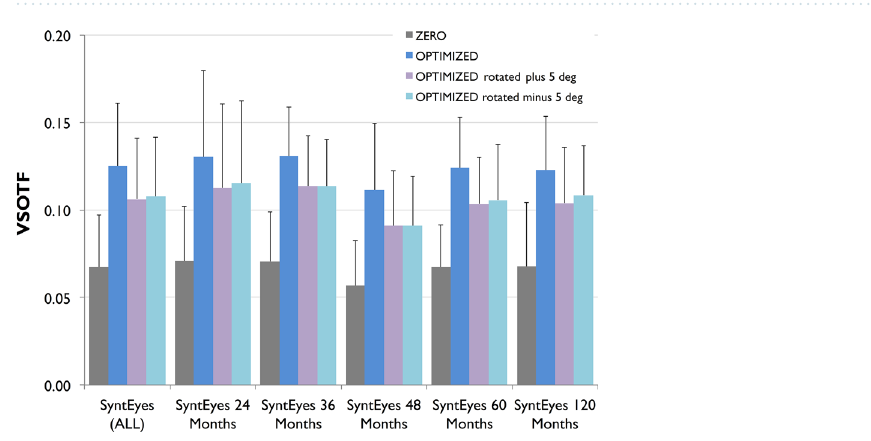
Figure 5. VSOTF magnitude for the original data (corneal astigmatism and HOAs, in red), zero target condition (zero defocus and astigmatism, in grey) and optimized calculation (sphero-cylindrical correction combined with the natural amount of HOAs, in light blue) and tolerance to ± 0.5D of defocus (zero target condition and optimized calculation).